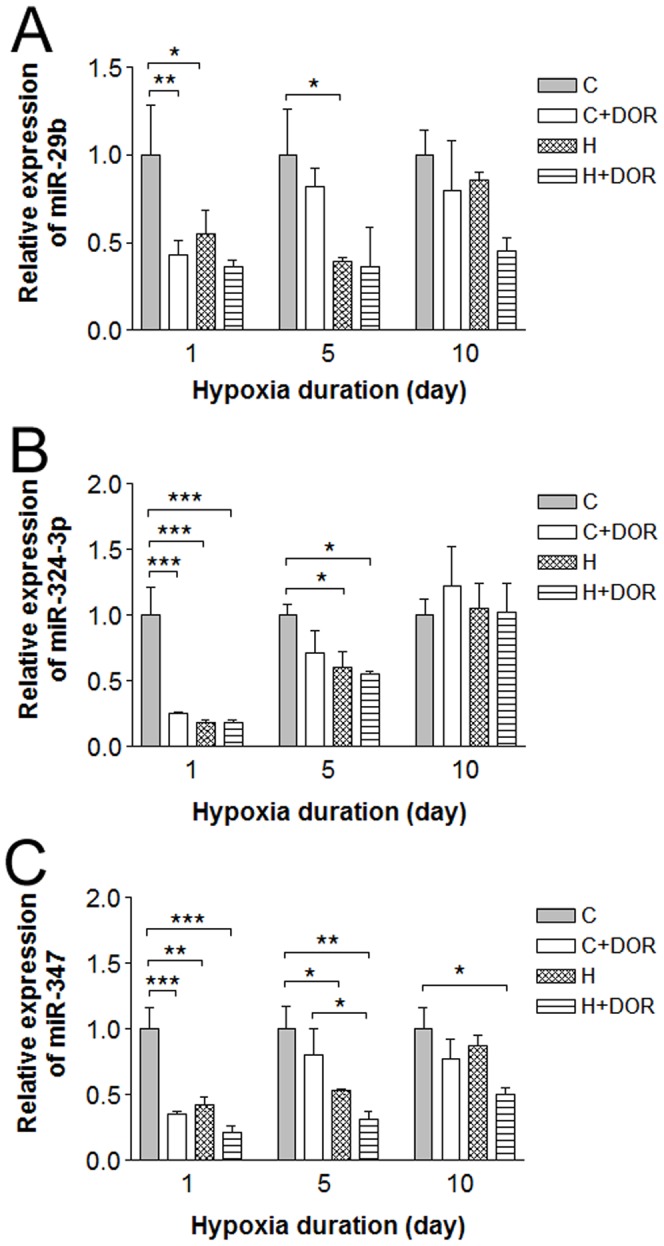
Relative miRNA expression levels of miR-29b, -324-3p and -347 in the cortex following 1, 5 or 10 days of hypoxia or UFP-512 treatment.C: control; C+DOR: control+DOR agonist UFP-512; H: hypoxia; H+DOR: hypoxia+ DOR agonist UFP-512. *p<0.05, **p<0.01, ***p<0.001. Note that miRNA expression levels of miR-29b, -324-3p and -347 were suppressed in earlier, but not later days (10-day) of hypoxia. UFP-512 suppressed these miRNAs’ expression in a similar way. These results suggest these miRNAs respond to hypoxia and DOR activation in the early period, but not in the extended duration.